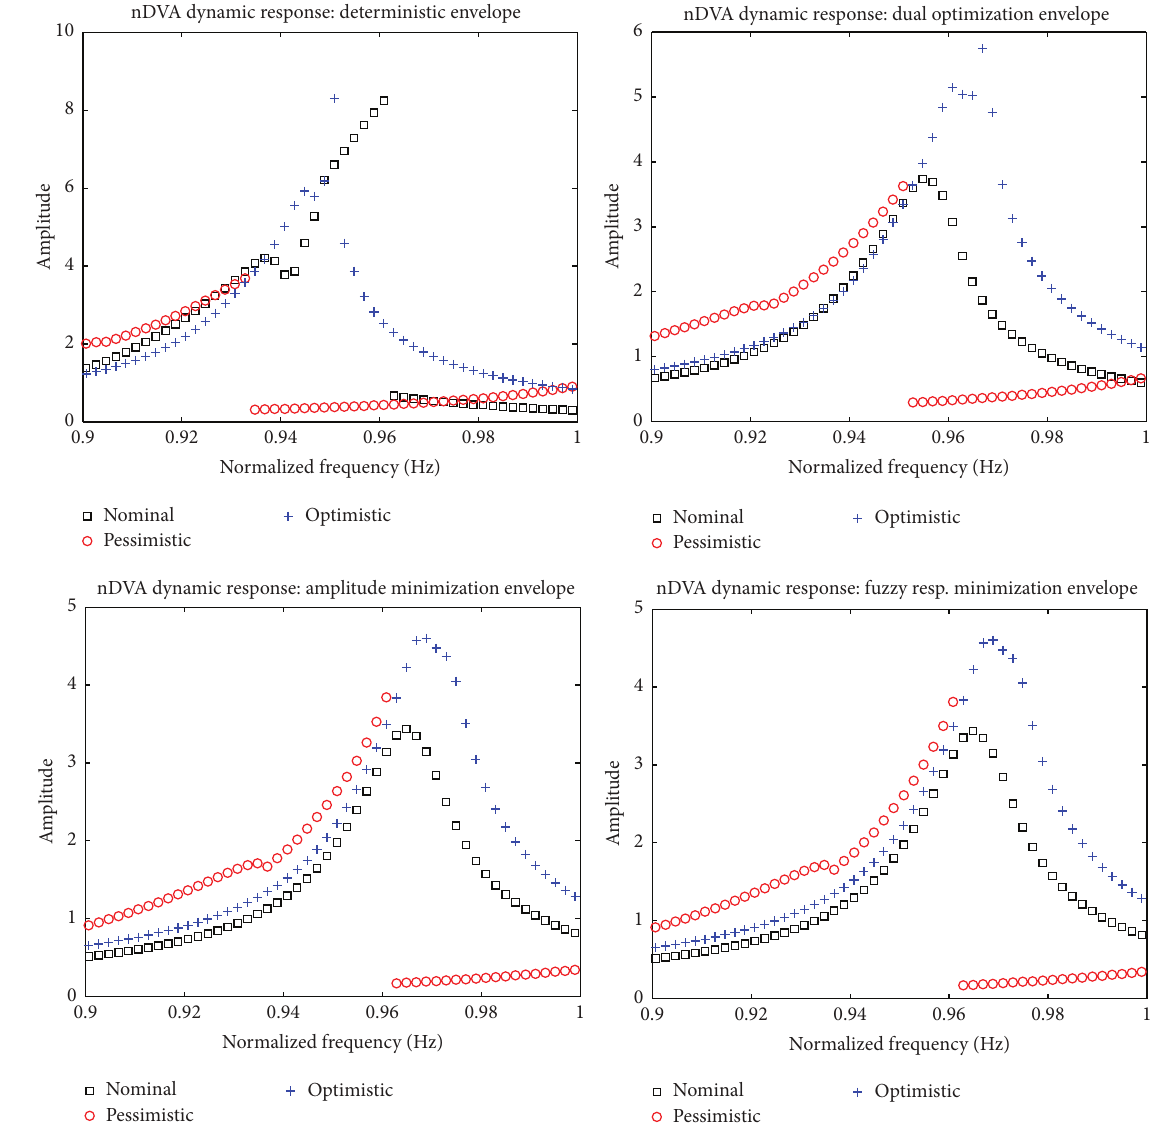
Figure 10: Robustness envelopes determined in the design of the